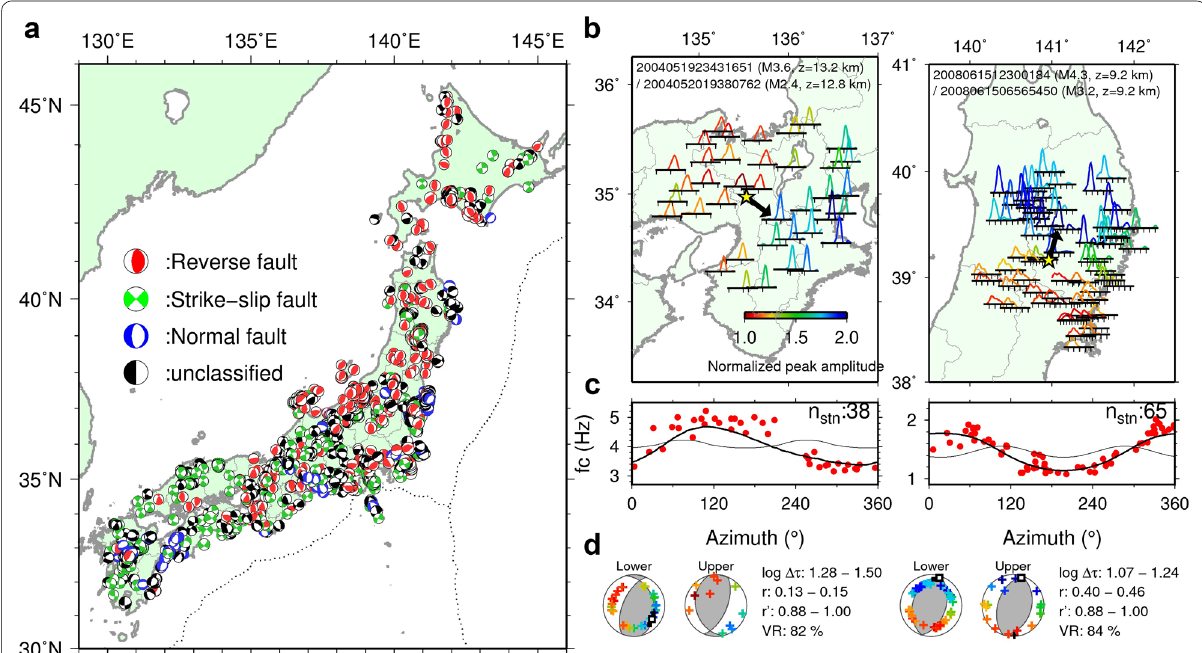
Fig. 1 Spatial distribution of the focal mechanisms and seismic stations used in this study. a Focal mechanisms (Mw 3.3–5.5) are shown by “beach ball” symbols. b Example AMRF distributions plotted at the locations of the seismic stations. Black arrows represent azimuths of rupture propagation. Tick marks denote 0.2 s intervals. c Relationships between azimuth and corner frequency of AMRFs. Black and gray curves show theoretical corner frequencies based on the best-fit generalized and symmetrical rupture models, respectively. For the computation, takeoff angles were assumed to be 90°. d The confidence regions of rupture propagation direction are shown on the beach balls symbols. Black squares show results within the confidence region. White squares show the best result. Crosses show the seismic